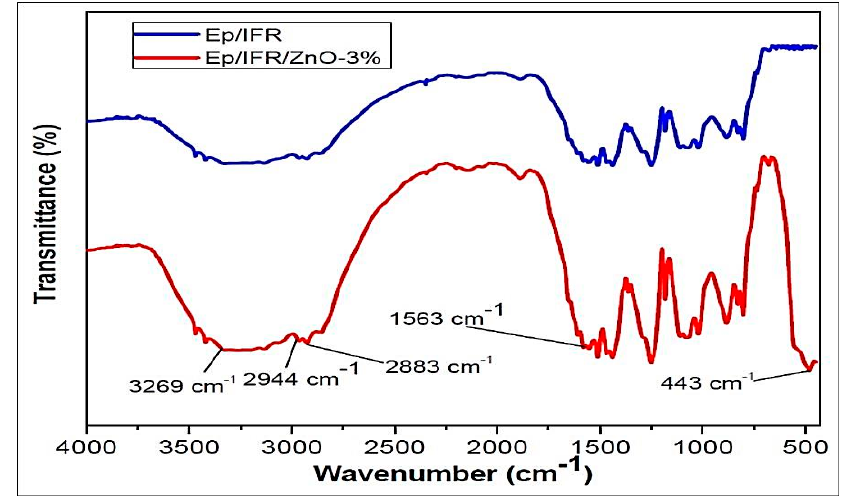
Figure 8. FTIR spectra of the formulation samples.